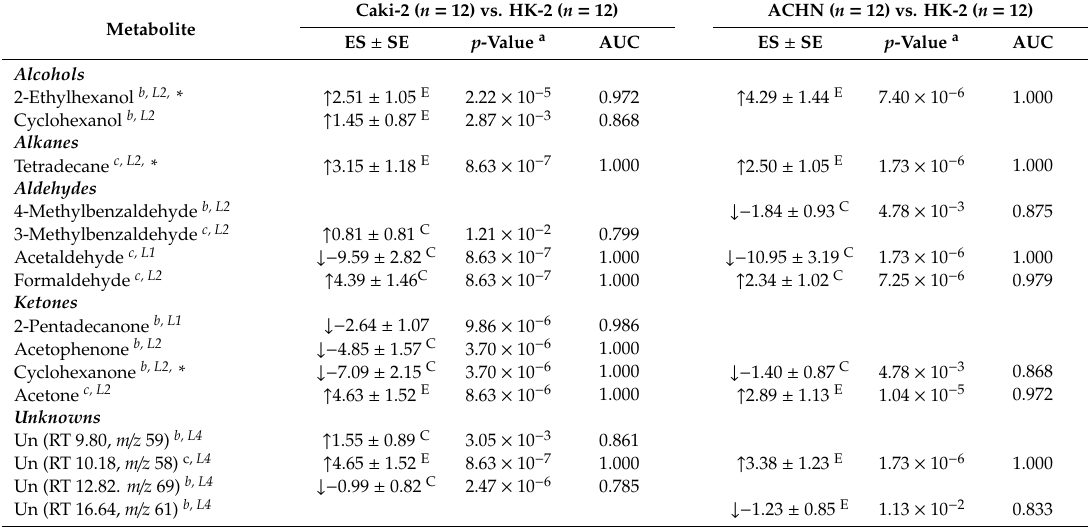
Table 2. List of volatile compounds (VOCs and VCCs) significantly altered between papillary renal cell carcinoma (pRCC; Caki-2 and ACHN) cell line and the non-tumoral cell line (HK-2). Caki-2 ( n = 12) vs. HK-2 ( n = 12) ACHN ( n = 12) vs. HK-2 ( n = 12) Metabolite ES ± SE p -Value a AUC ES ± SE p -Value a AUC ↑ 2.51 ± 1.05 E 2.22 × 10 − 5 0.972 ↑ 4.29 ± 1.44